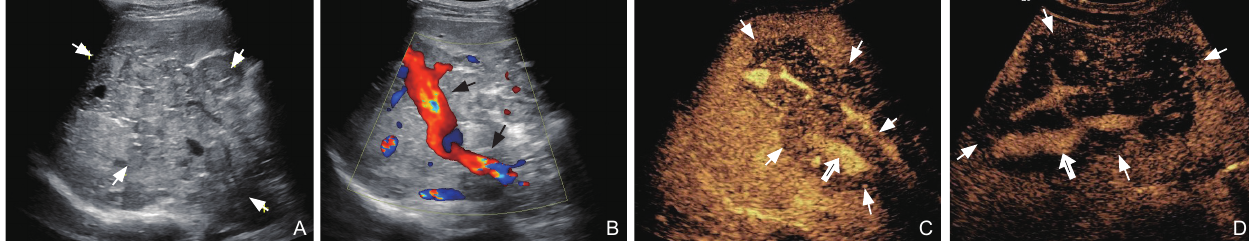
Figure 1 Abdominal ultrasonography. (A) Conventional US showed massive intrahepatic heterogeneous hypo-echoic lesion (arrows) with irregular shape and unclear margin measured approximately 14×6.5cm; (B) The well-perfused portal vein (arrows) diffusion through the lesion could be observed on CDFI; (C) CEUS demonstrated hypo-enhancement of the perivascular lesion (arrowheads) at portal phase (38s after contrast agent injection), with integrated preservation of the portal vein (open arrow) and hepatic artery (solid arrow); (D) The periportal lesion (arrowheads) remained hypo-enhanced at delayed phase. The portal vein (open arrow) presented well-perfused.